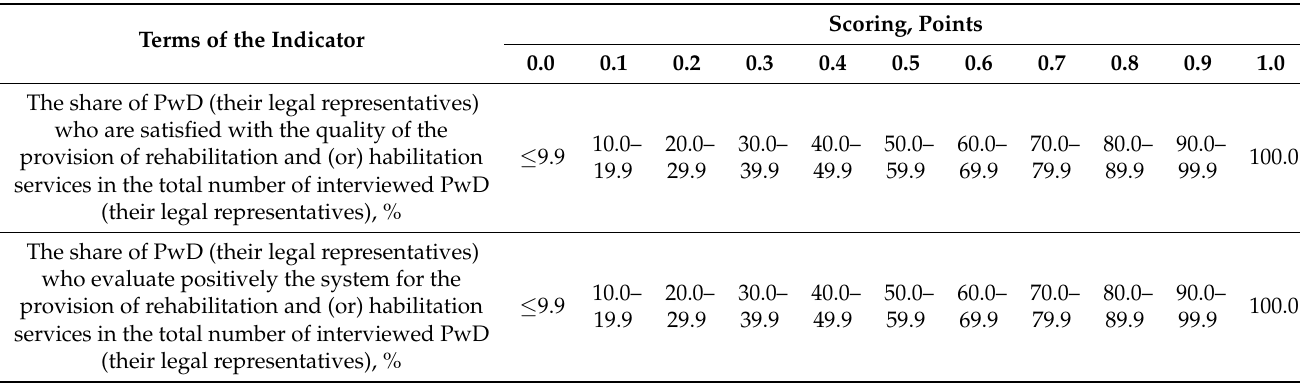
Table A2. Scoring of the indicator “The satisfaction of PwD (their legal representatives) with